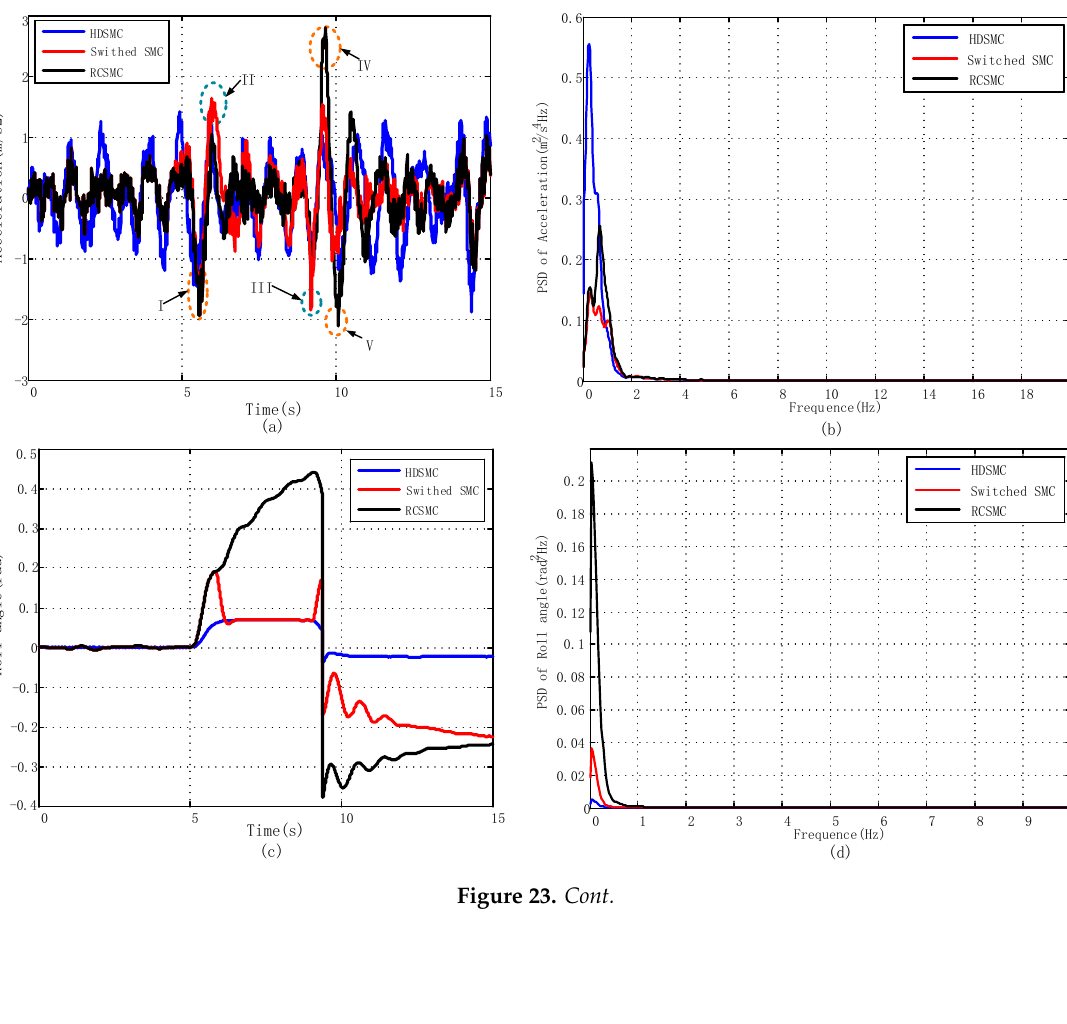
Time(s) Time(s) (a) (a)